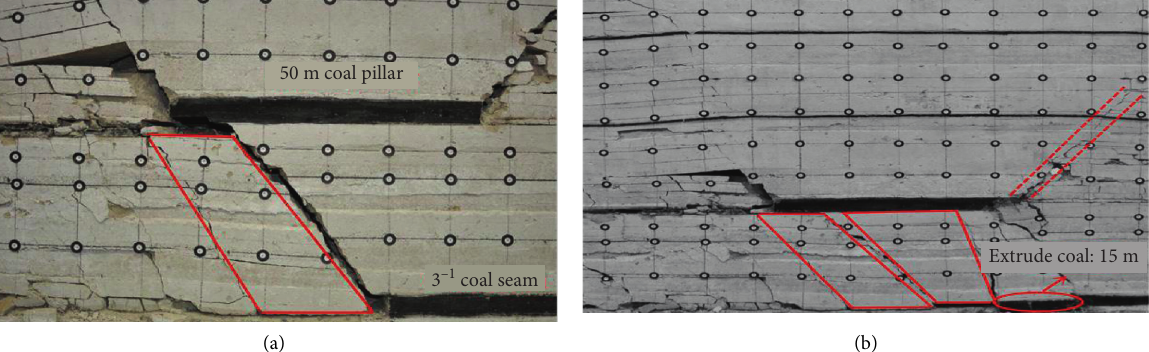
Figure 10: The overlying rock strata movement when crossing the coal pillar. (a) When crossing the coal pillar of 50m. (b) When the coal pillar of 50m was